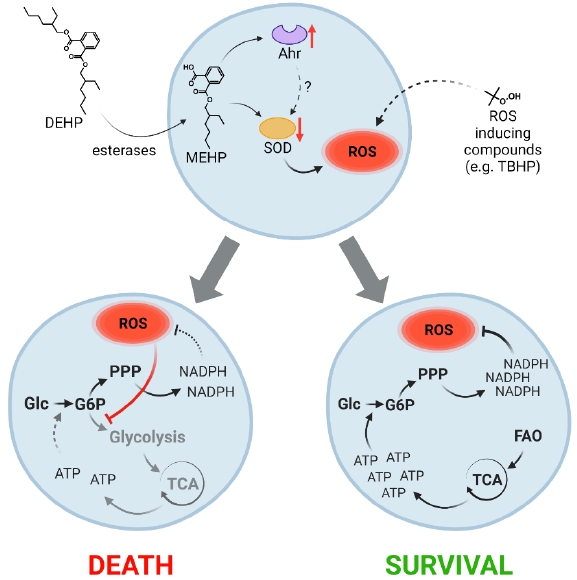
Figure 5. Active fatty acid oxidation increases the capacity for reactive oxygen species (ROS) quenching regardless of the nature of the stimulus. Model depicting the critical role of active fatty acid oxidation (FAO) in generating adenosine triphosphate (ATP) to support glucose (Glc) phosphorylation (to glucose-6-phosphate (G6P)), resulting in pentose phosphate pathway (PPP) activity. Administration of di-2-ethylhexyl phthalate (DEHP) results in the accumulation of ROS due to reduction of superoxide dismutase (SOD) activity mediated by its metabolite, mono-2-ethylhexyl phthalate (MEHP). The observed reduction in SOD activity may be the result of MEHP-dependent dysregulation of aryl hydrocarbon receptor (AhR) signaling. ROS can also be formed in response to unrelated mechanisms (e.g., in response to tert-butyl hydroperoxide (TBHP)). Increased concentrations of ROS redirect the glycolytic flux through PPP, leading to reduced levels of ATP (also via reduced tricarboxylic acid cycle (TCA) activity) in cells that are incapable of active FAO (left). Reduced levels of ATP result in reduced rates of glucose phosphorylation and NADPH generation, which are factors that ultimately lead to cell death. In cells capable of active FAO, ATP is generated by a mechanism that does not rely on glycolysis. These cells produce higher levels of NADPH and are thus able to quench toxic ROS (right).